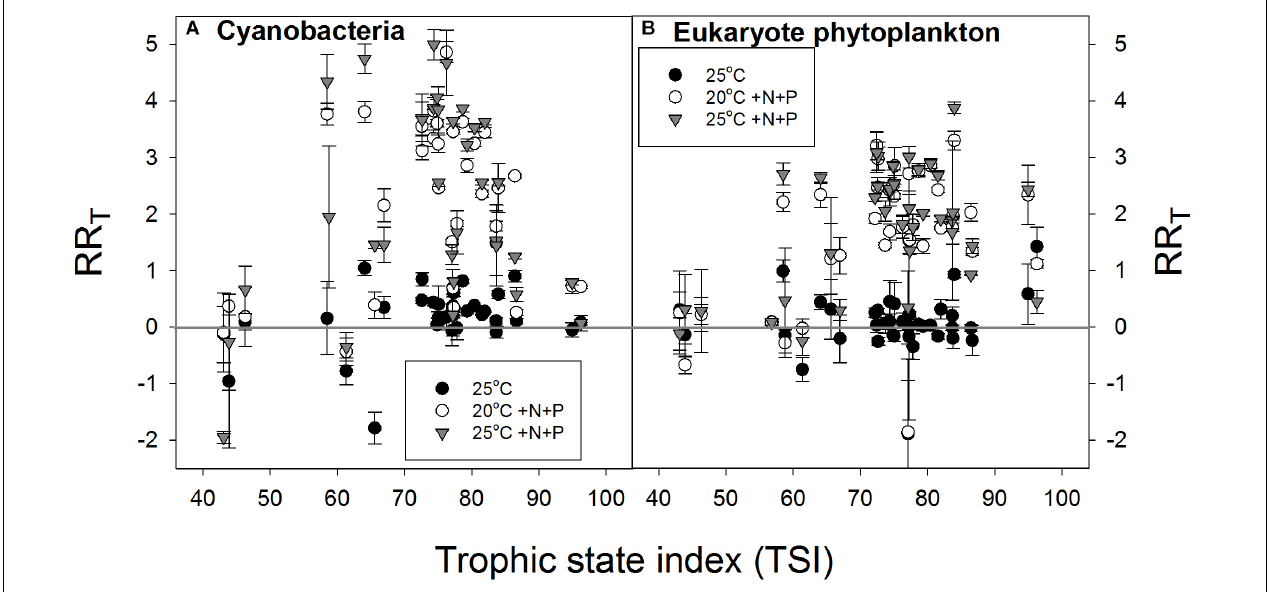
FIGURE 6 | Response ratios (RR T ), which is the natural logarithm of the quotient of chlorophyll-a concentration ( µ g l − 1 ) in a treatment and control (20 ◦ C), for cyanobacterial chlorophyll-a concentrations (A) and eukaryote phytoplankton chlorophyll-a concentrations (B) in warmed (25 ◦ C, filled circles), nutrient enriched (20 ◦ C +N+P, open circles) and both warmed + nutrient enriched (25 ◦ C +N+P, gray triangles)